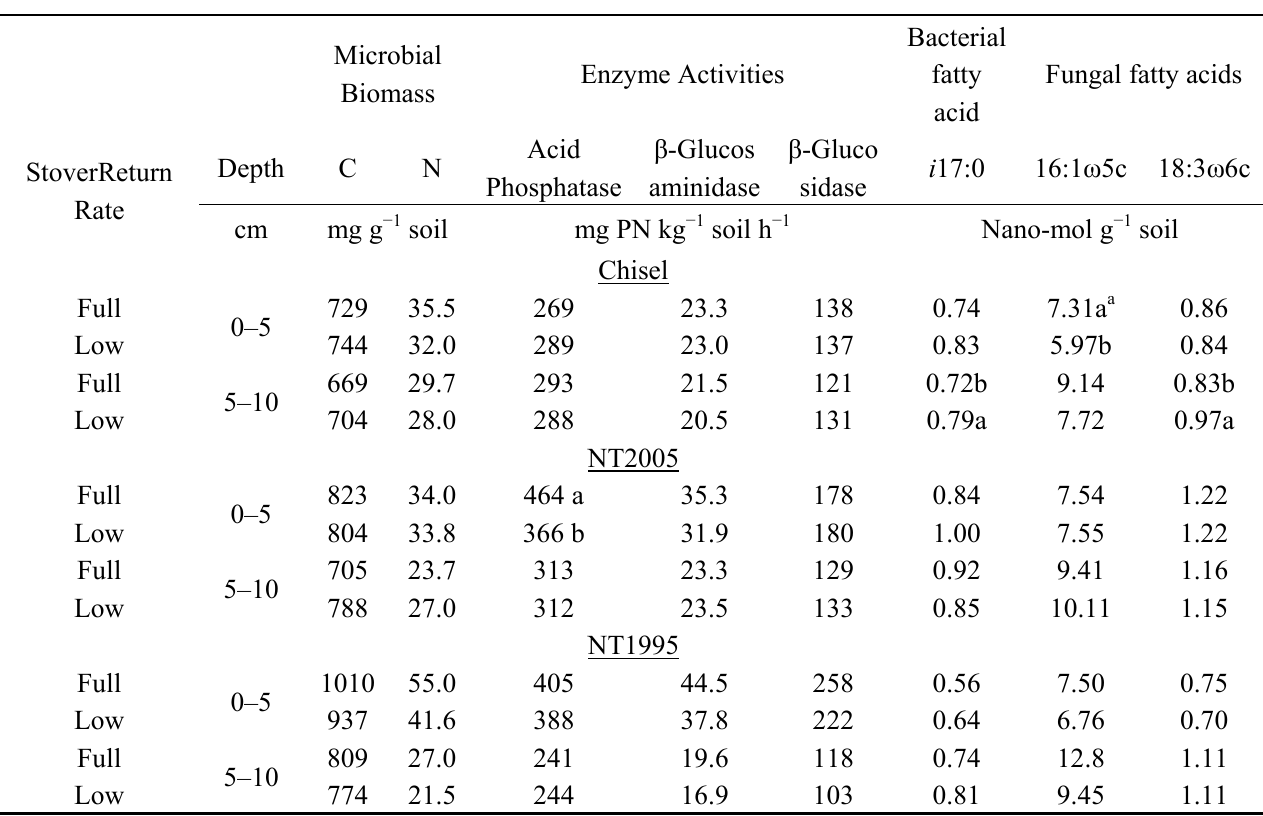
Table 5. Biological parameters as affected by stover return rates in three fields with different tillage management.